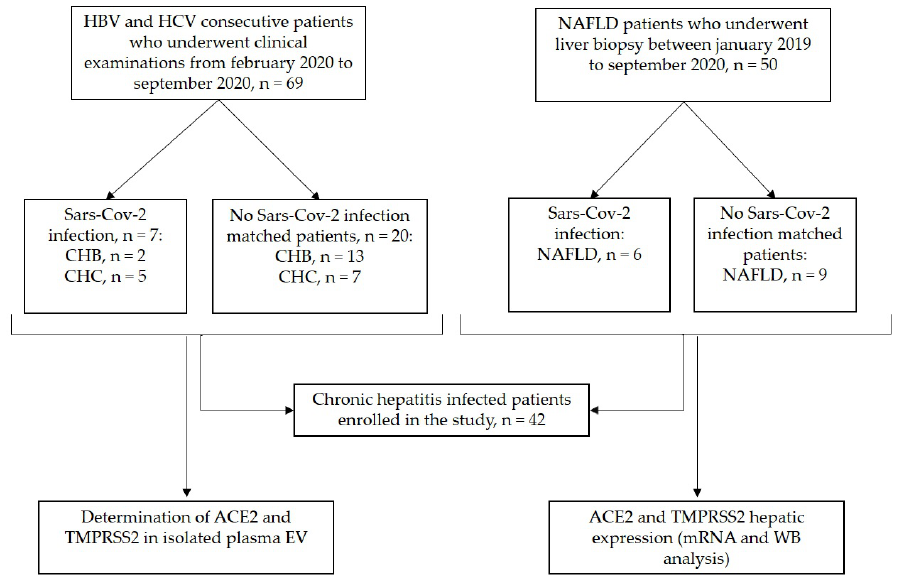
Figure 1. Flow chart of the study. ACE2, angiotensin converting enzyme 2; CHB, chronic hepatitis B; CHC, chronic hepatitis C; NAFLD, non-alcoholic fatty liver disease; SARS-Cov-2, severe acute respiratory coronavirus virus 2; TMPRSS2, transmembrane serine protease